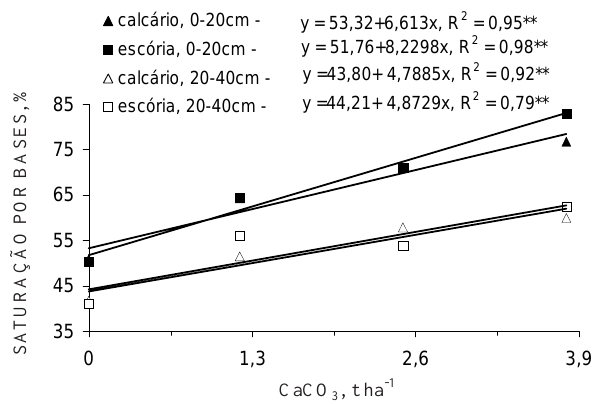
Figura 3. Efeito da aplicação do calcário e da escória de siderurgia na saturação por bases de um Latossolo Vermelho-Amarelo cultivado com cana-de-açúcar, nas profundidades de 0- 20 e 20-40 cm. (Dados médios de duas épocas de amostragens e quatro repetições).